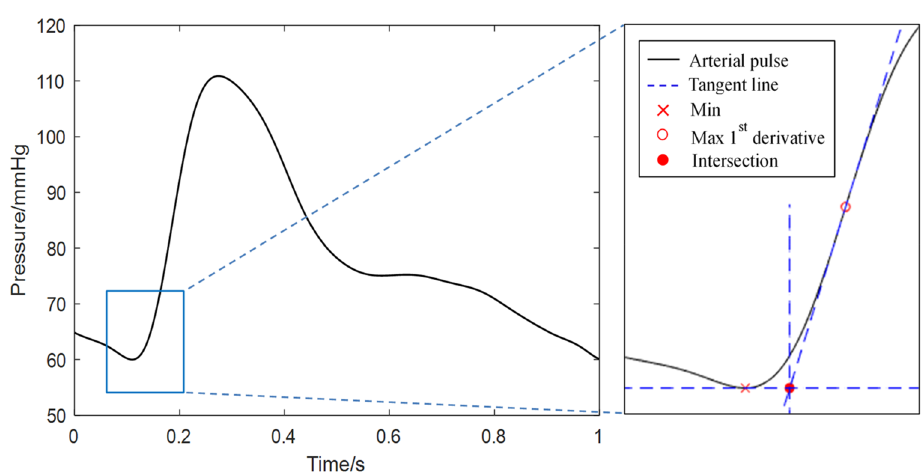
Figure 3. Graphical representation of the intersecting tangent method. The intersection point is taken as the fiducial point for determining